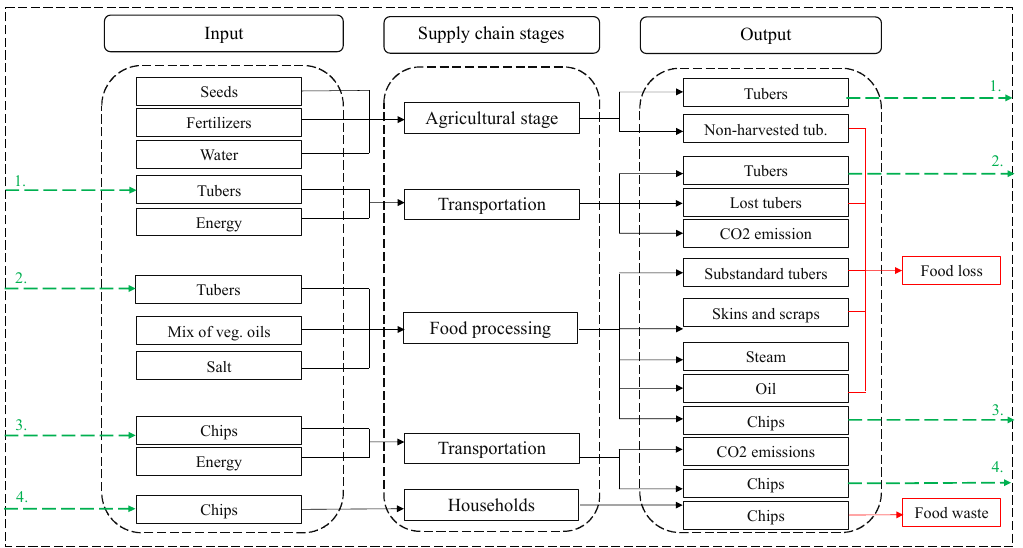
Figure 1. “Chips system” diagram. Notes: Green lines illustrate food flows (i.e., tubers and chips), whereas red lines identify food loss and food waste flows (i.e., non-harvested tubers, substandard tubers, skins and scraps, oil waste and chips waste). Number 1 links tubers from the agricultural stage to tubers at the transportation stage. Number 2 links tubers from the transportation stage to tubers at the food processing stage. Number 3 links chips from the food processing stage to chips at the transportation stage. Number 4 links chips from the transportation stage to chips at the household consumption stage. Source: Personal elaboration by the authors.